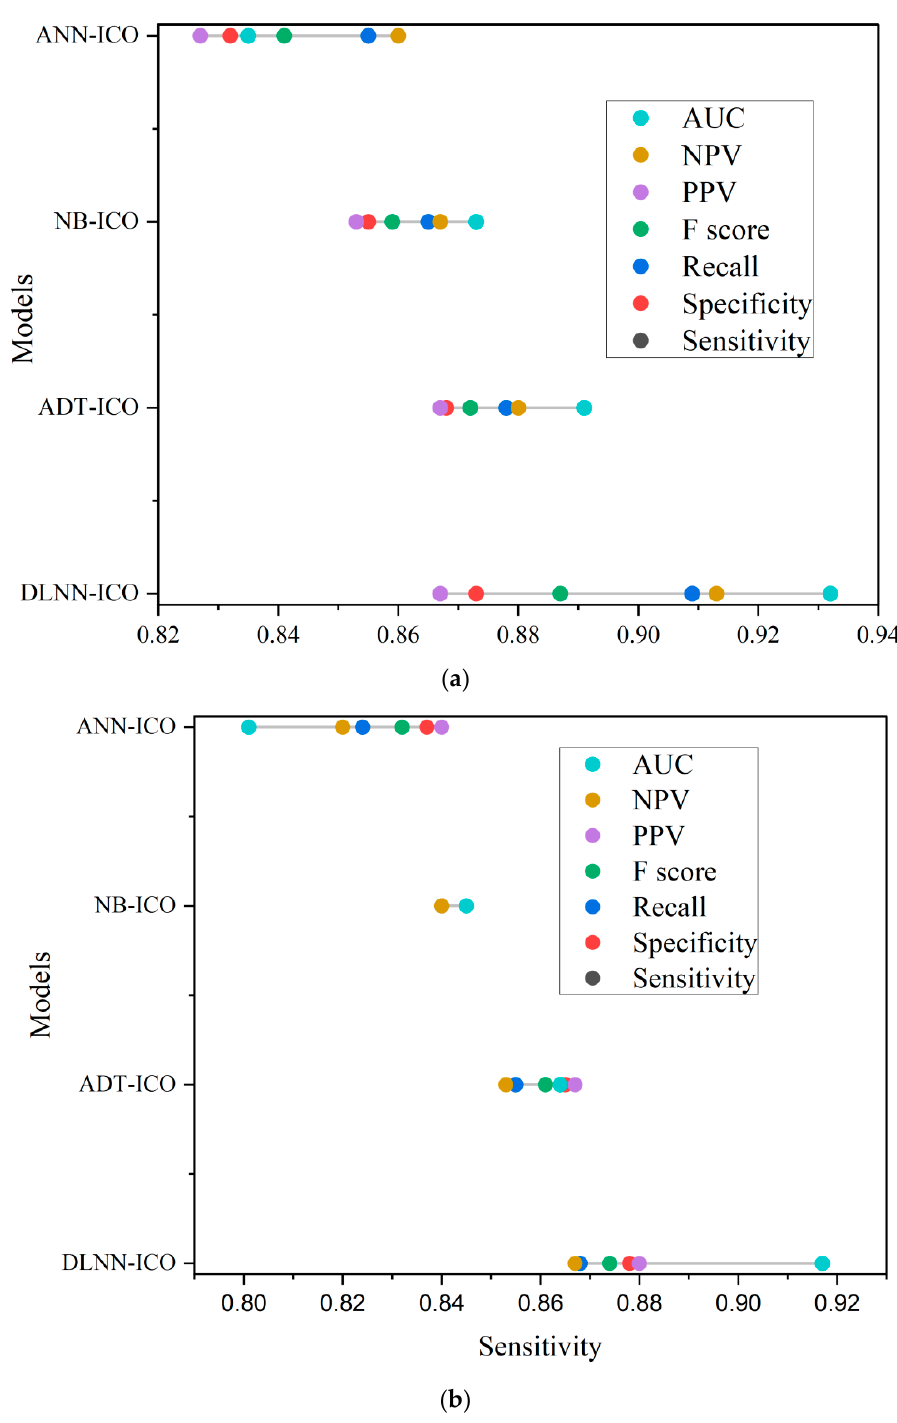
Figure 7. Validation of the model when considering the training ( a ) and validation ( b )